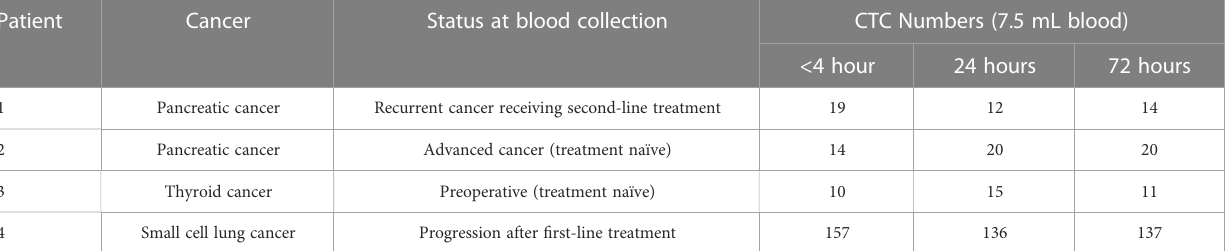
TABLE 3 Number of CTCs detected according to post-collection processing time.